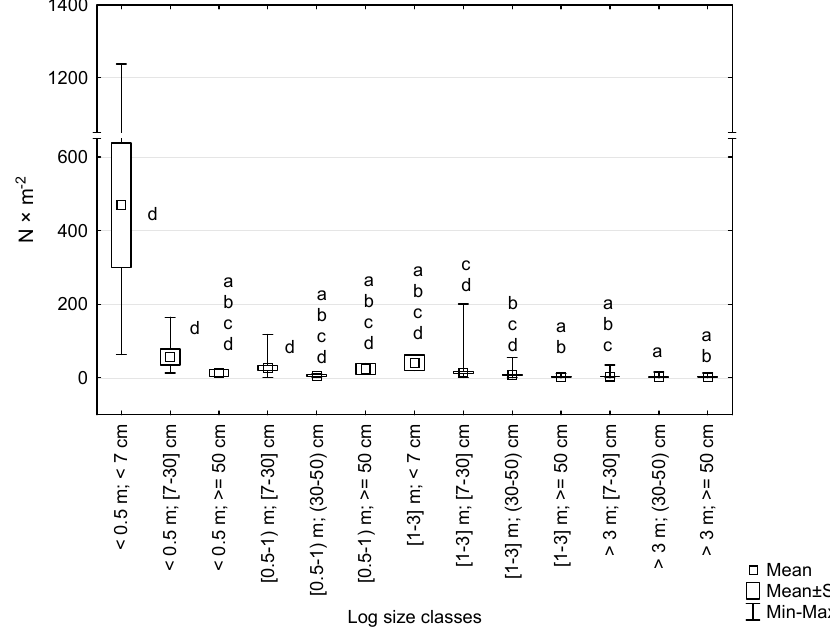
Figure 4. Sporophyte density on logs depending on their size classes (length, m; diameter, cm). Values designated by different letters differed significantly ( p < 0.05) according to the Kruskal-Wallis test and multiple comparisons of the mean ranks for all groups of variables. The Kruskal-Wallis test results were as follows: H (12, N = 505) = 166.7670, p < 0.001.